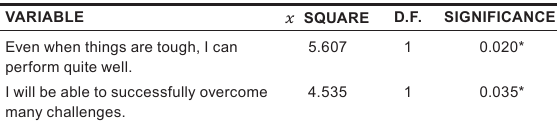
table 7 Chi-square-based measures of association between I am more aware of many new venture situations, some of which succeeded and some of which failed, and why or